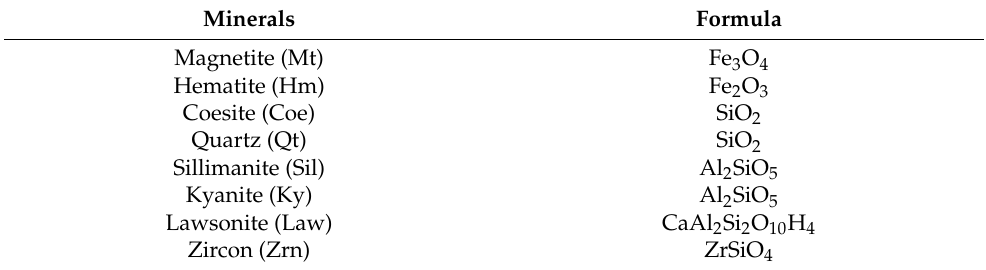
Table 3. Pure minerals considered in the modelling. The thermodynamic properties are from Holland and Powell